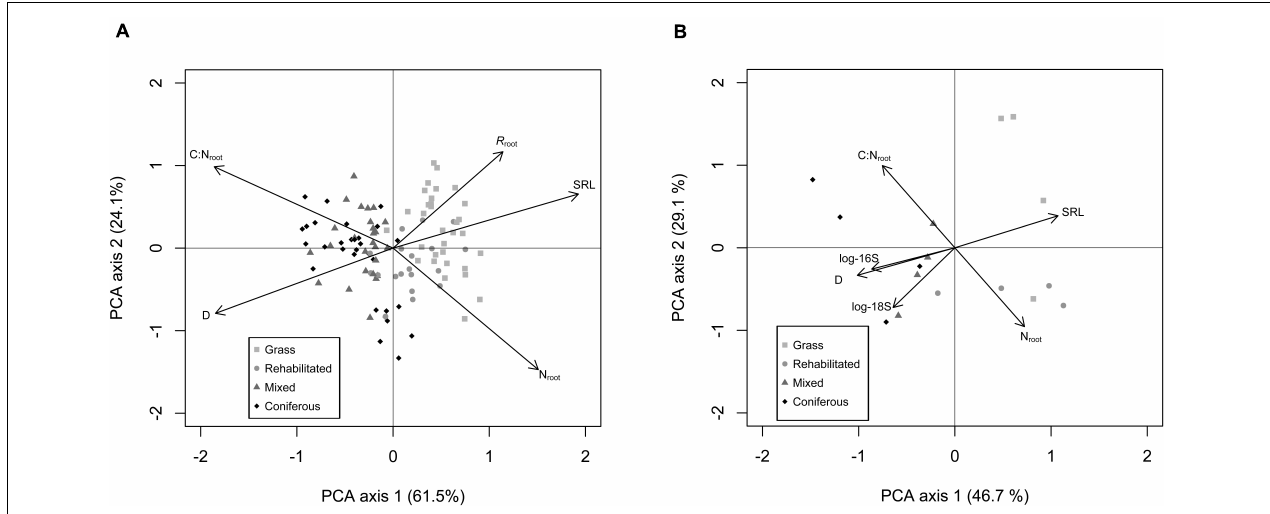
FIGURE 2 | Principal component analysis (PCA) of absorptive fine root traits: D = average root diameter (mm); C:N root = root C to N ratio; SRL = specific root length (m g - 1 ); N root = root N content (mg g - 1 ); R root = specific root-rhizosphere respiration (nmol CO 2 g - 1 s - 1 ) from full data set ( n = 120) (A) . PCA of absorptive fine root traits measured with paired rhizosphere soil analysis of bacterial (16S) and fungal (18S) abundance (B) . TABLE 2 | Coefficients of linear mixed models to predict total soil respiration ( R s ), heterotrophic respiration ( R h ), and autotrophic-rhizospheric respiration ( R a + r ). Soil variables Root